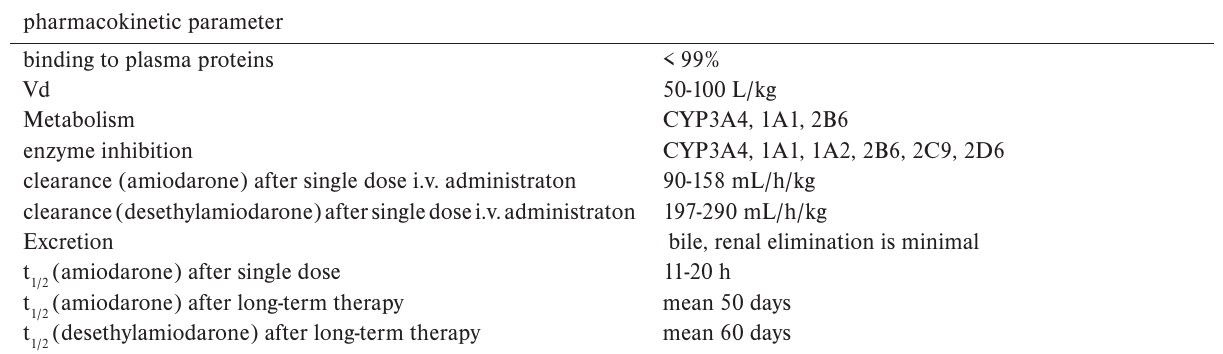
Table 1. Amiodarone pharmacokinetic profile (9,10,15,24)